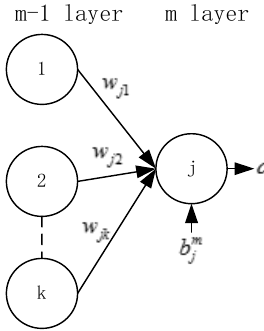
Figure 4. The basic structure of the back propagation (BP) network.